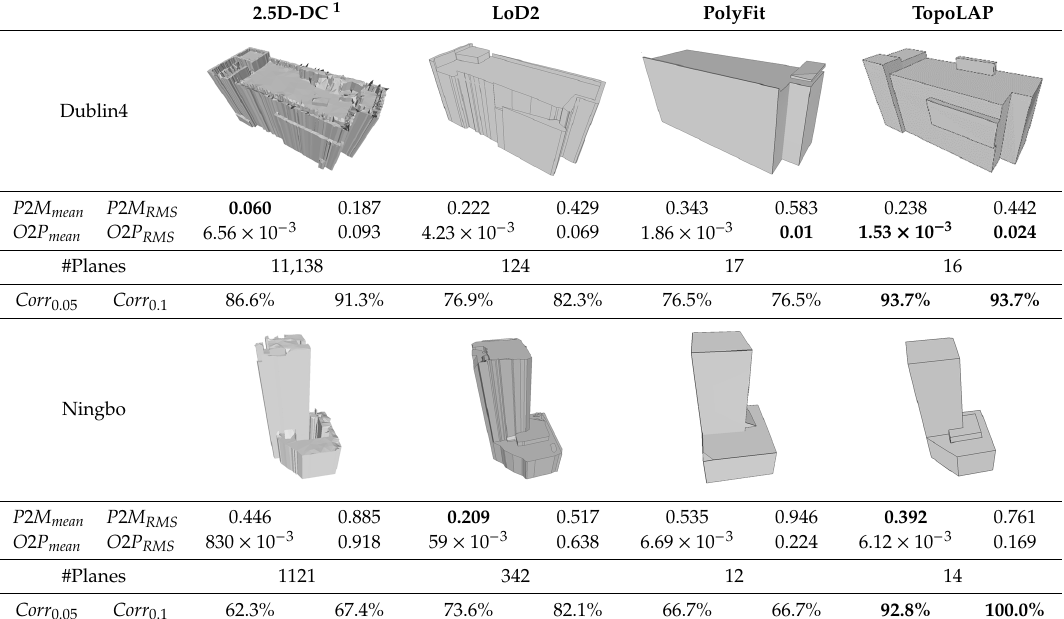
Table 4. Visual and quantitative comparison to the related works.